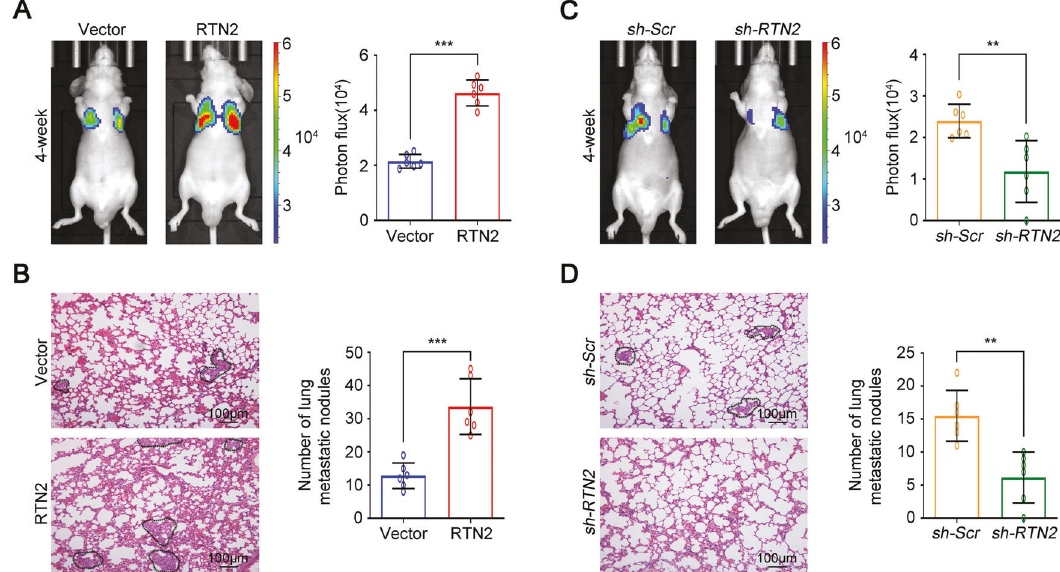
Fig. 4 RTN2 promotes metastasis of gastric cancer cells in vivo. Stable MGC80-3 cells were injected into the lateral tail vein of mice as described in the “ Materials and Methods ” , and photon fl uxes were monitored 4 weeks later. A , B The effects of RTN2 overexpression on metastasis of gastric cancer cells. A The luminescent tumour signals were measured (right panel, n = 6), and representative images were shown (left panel). B Representative hematoxylin-eosin staining of the lung for each group (left panel), micrometastatic lesions were indicated with a dotted line. Numbers of lung metastatic foci in each group were counted (right panel). C , D The effects of RTN2 knockdown on metastasis of gastric cancer cells. D The luminescent tumour signals were measured (right panel, n = 6), and representative images were shown (left panel). D Representative hematoxylin-eosin staining of the lung for each group (left panel), micrometastatic lesions were indicated with a dotted line. And numbers of lung metastatic foci in each group were counted (right panel). In ( A – D ), data are represented as mean ± SD, and statistical signi fi cance was calculated by Student ’ s two-tailed t test. ** P < 0.01; *** P <